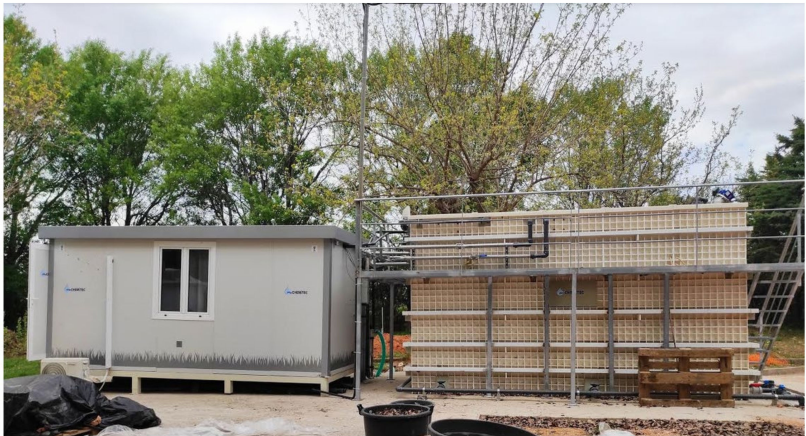
Figure 6. Overview of the sewer mining unit and the control